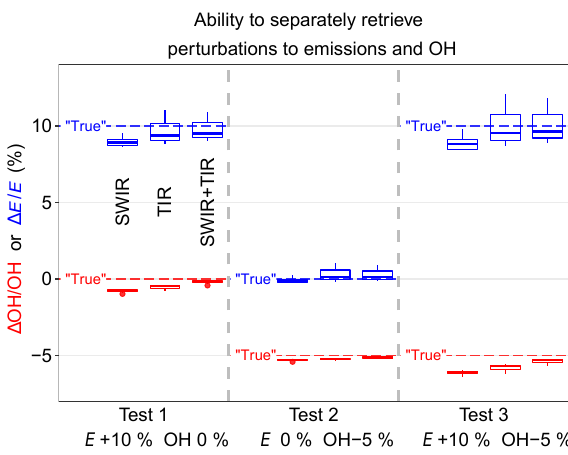
Figure 8. OSSE experiments perturbing global emissions ( E + 10%), OH (OH-5%), and both ( E + 10% OH-5%) to test whether the inversion can retrieve these perturbations separately. Results are shown for different satellite observing systems (SWIR, TIR, and SWIR + TIR). Blue symbols represent posterior estimation of changes in emissions, and red symbols posterior estimation of change in global OH concentration. The boxes represent the 75th, 50th, and 25th percentiles, and the whiskers represent the maximum and minimum of the results using 12 different OH distributions in true simulations. Dashed lines are true changes in global emissions (blue) and OH concentration